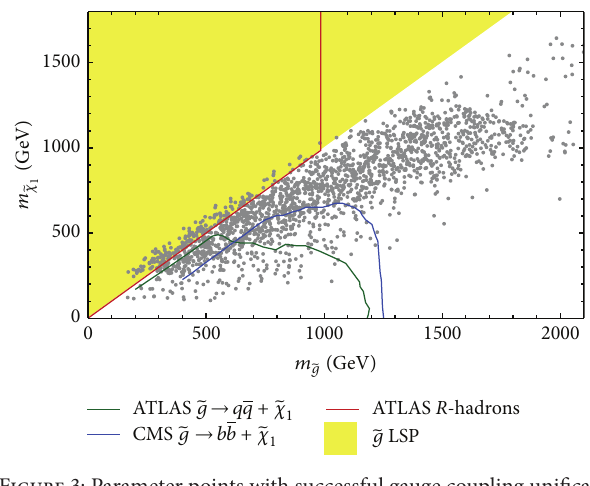
Figure 3: Parameter points with successful gauge coupling unifica- tion (gray). Also shown are representative constraints on the gluino mass for the decay modes ̃𝑔 → 𝑞 𝑞+ ̃𝜒 [1] and CMS [2]. The yellow region features a gluino LSP which is constrained by the ATLAS search for stable 𝑅 -hadrons.